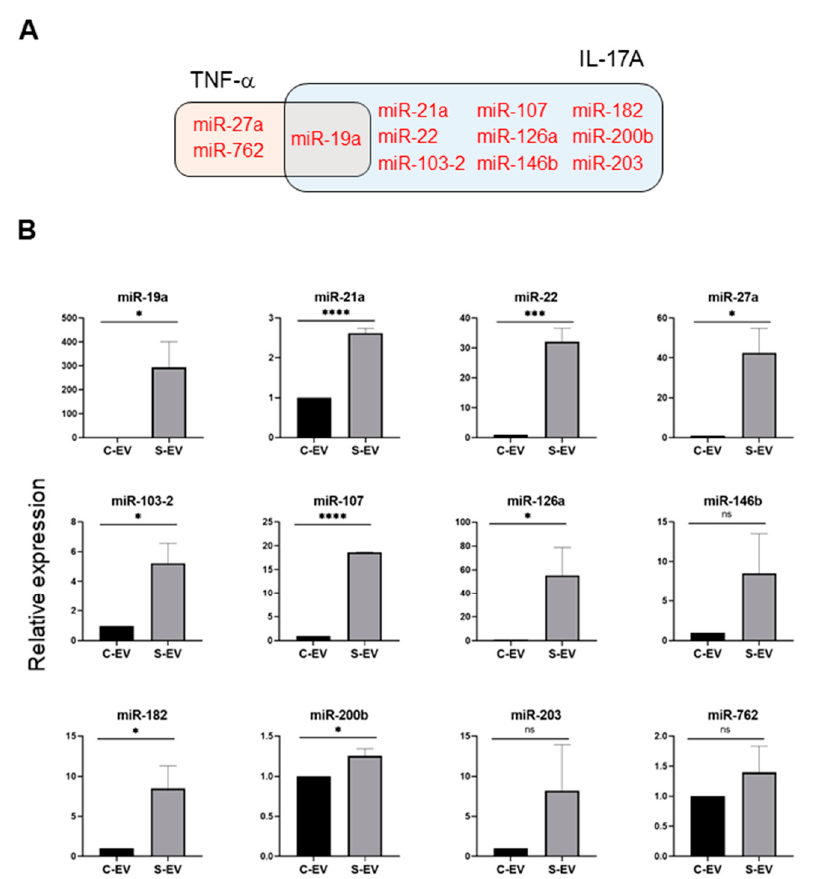
Figure 4. Sepsis EVs (S-EVs) enrich 12 chosen miRNAs expected to target TNF- α and IL-17A . ( A ) Among sepsis-augmented miRNAs in S-EVs, 12 miRNAs shown in Venn diagram were selected to further analyze their expressions. ( B ) RT-qPCR analysis for miRNA expressions in the EVs. These miRNAs were tested for their increased enrichment in S-EV. As a control, U6 was used to normalize miRNA levels. Total RNAs were isolated from EVs pooled from 5 mice in each group. At least four separate experiments were performed. Results are shown as the mean ± SEM. S-EV, sepsis EVs; and C-EV, control EVs. * p < 0.05; *** p < 0.001; **** p < 0.0001; and ns, not significant.